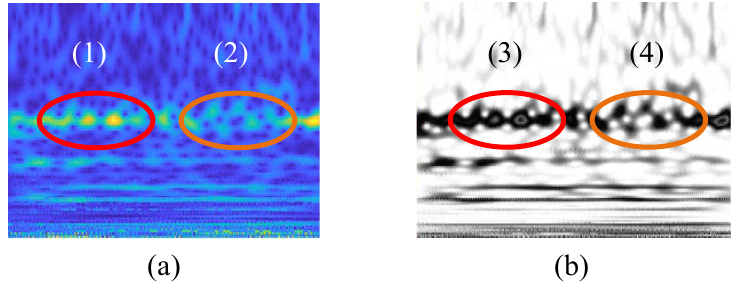
Figure 12. The outer ring fault features identified by BayesianPDL framework. ( a ) input feature map; ( b ) identified feature map. (1) and (2) is the fault feature of the input. (3) and (4) is the identified fault feature.